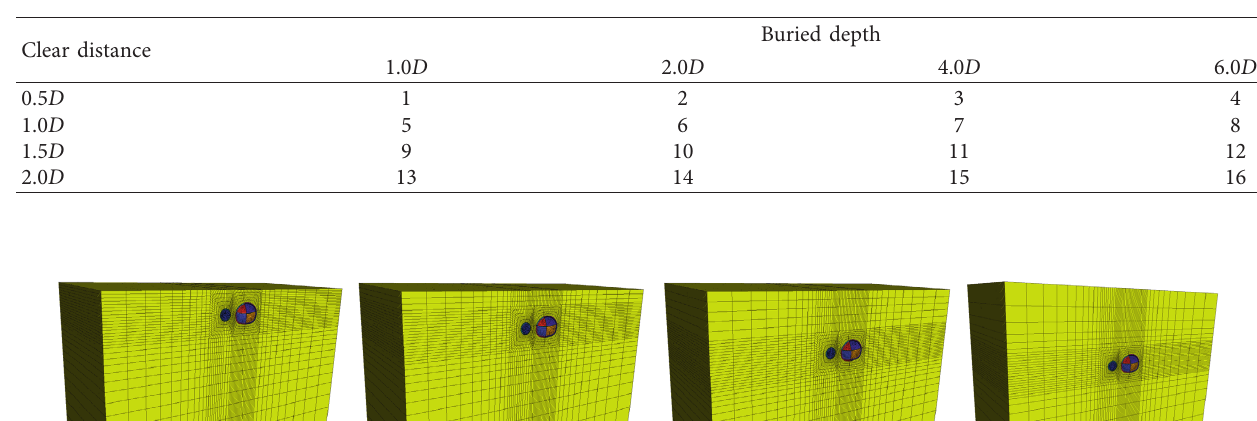
Table 10: Numerical simulation conditions and numbers.